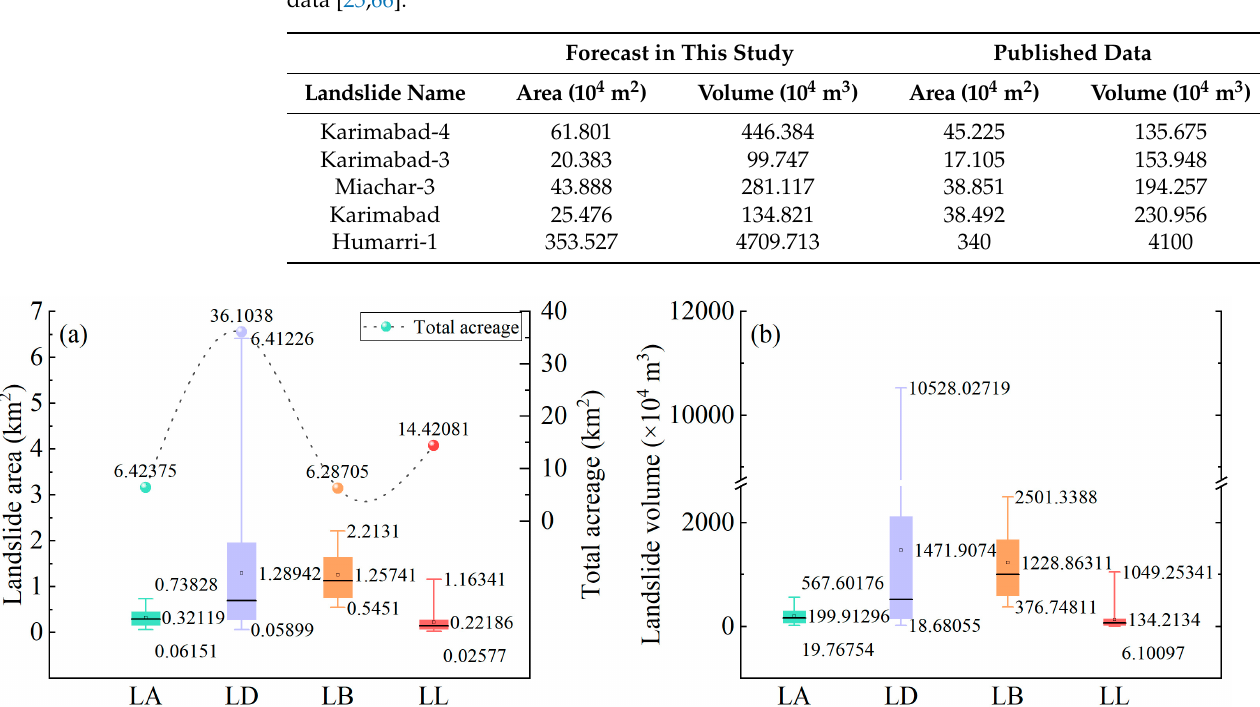
Figure 10. Analysis of multi-source landslide development characteristics of ( a ) area and ( b ) pre- dicted volume.